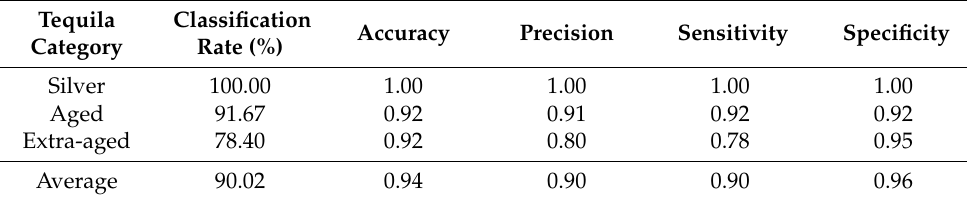
Table 3. Average classification results of EE for the discrimination of different tequila samples according to expected categories employing PCA-LDA.